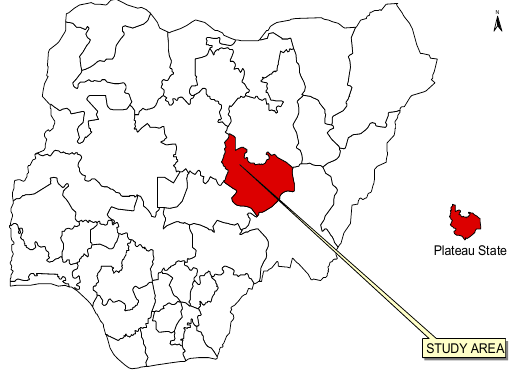
Figure 1. Map of Nigeria showing study